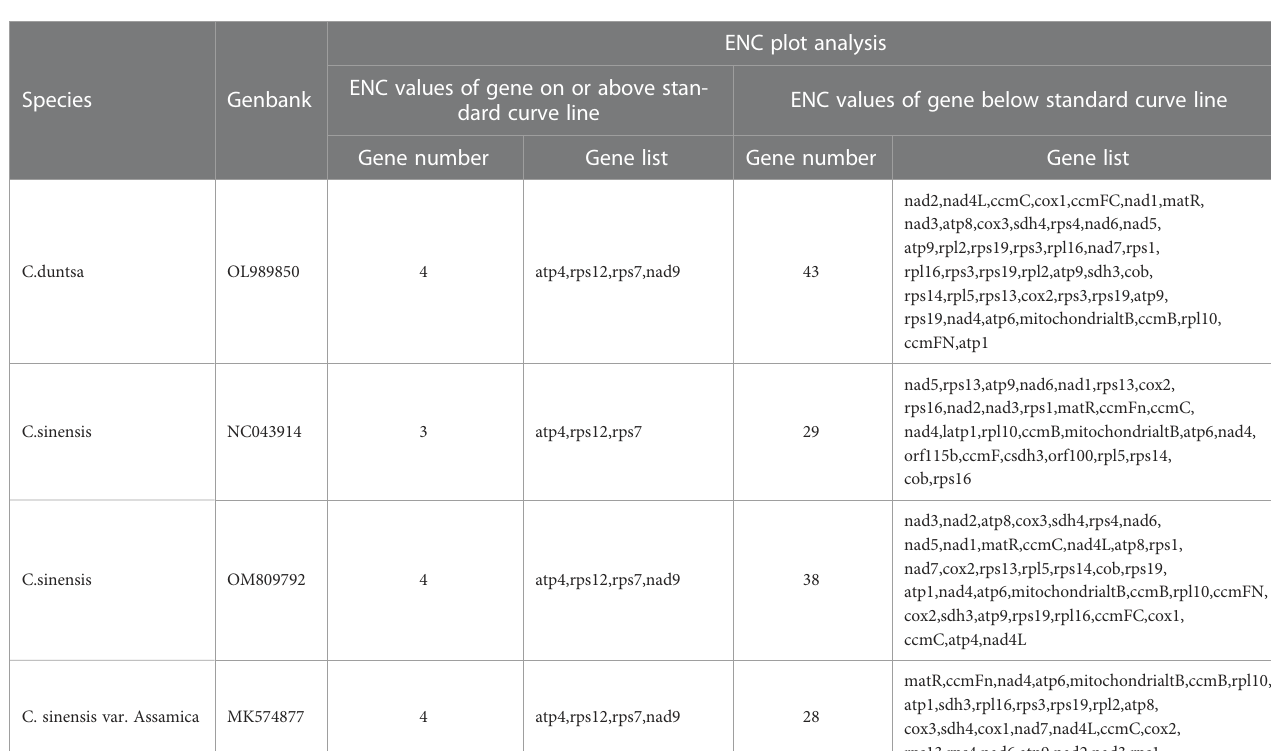
TABLE 2 Plot of ENC of genes in 4 Theaceae species mitochondrial genome.